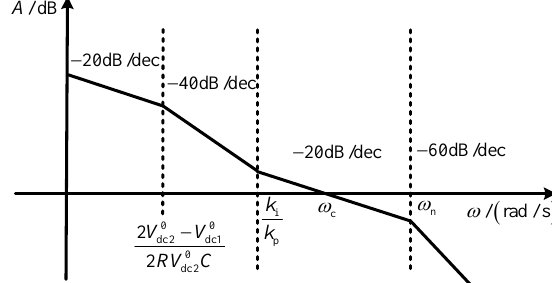
Figure 7. Bode diagram of voltage open-loop control.